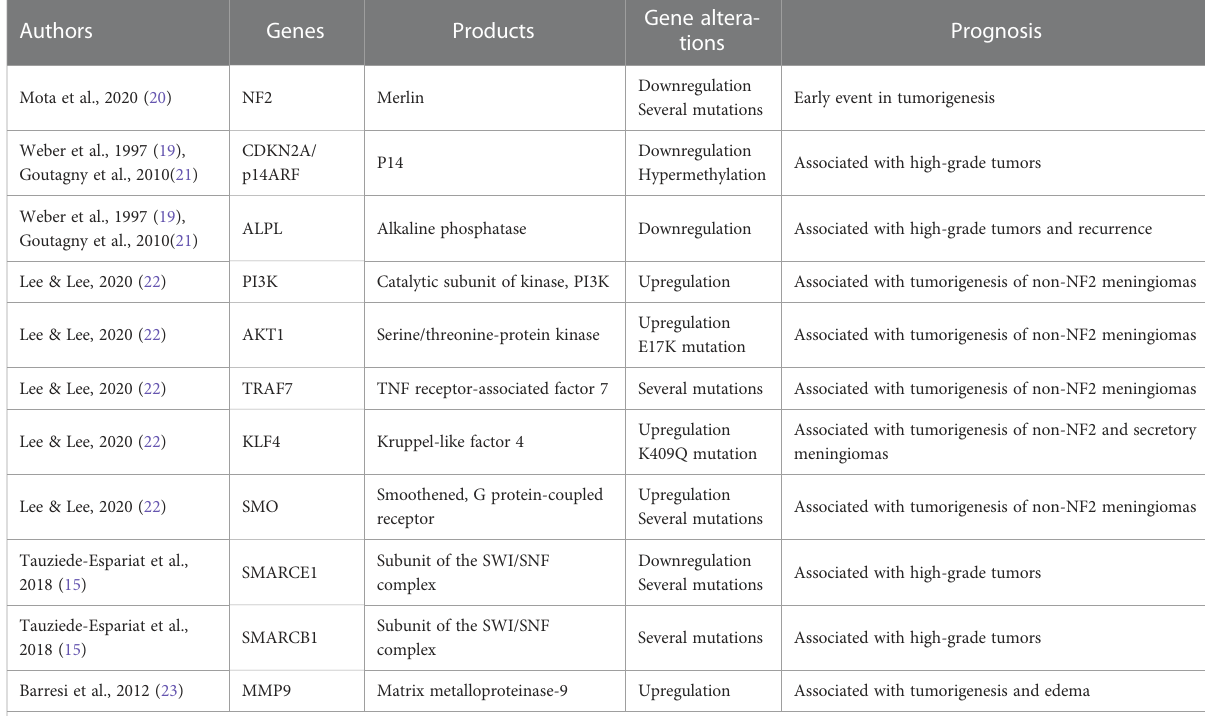
TABLE 2 Main molecular alteration and their prognosis in